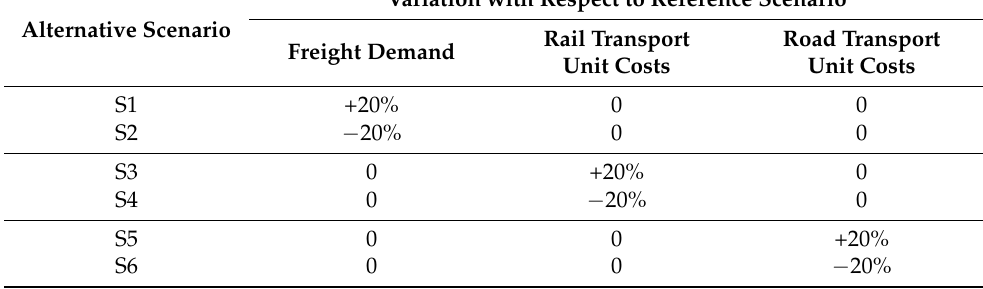
Table 7. Alternative scenarios defined for the sensitivity analysis.